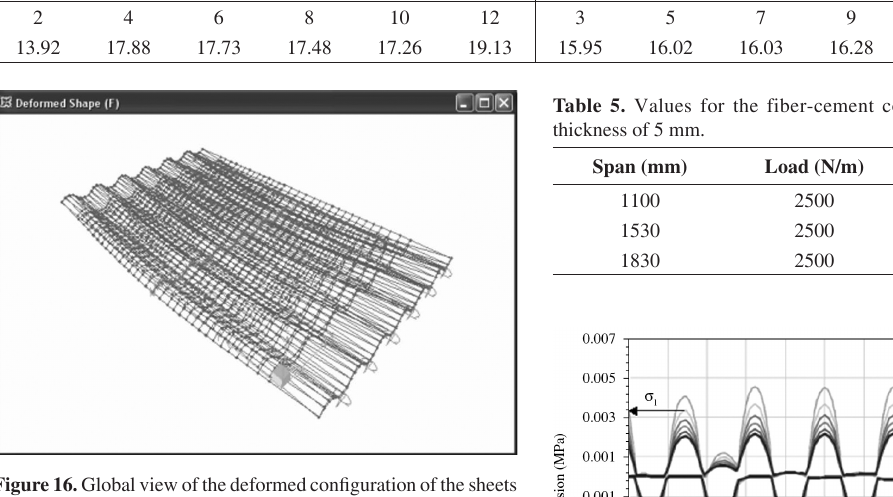
Table 4. Values of maximum longitudinal stresses in the model with span of 1830 mm. (MPa) in the high wave (compression) σ min